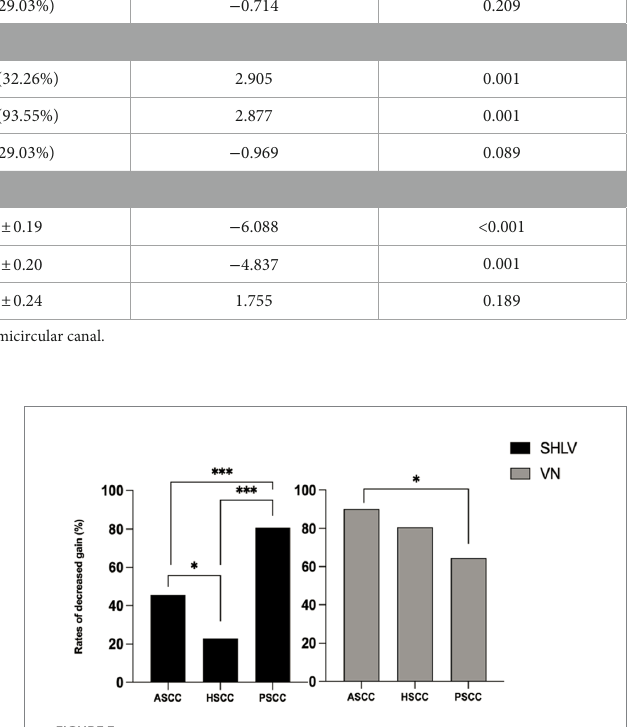
FIGURE 3 Comparison between the incidences of decreased VOR gain in anterior semicircular canal (ASCC), horizontal semicircular canal (HSCC) and posterior semicircular canal (PSCC) on the affected sides in SHLV patients and VN patients. * p < 0.05, *** p < 0.001.